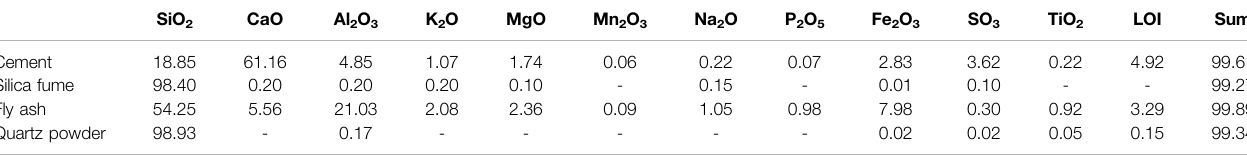
TABLE 1 | Chemical compositions of raw materials (wt%).